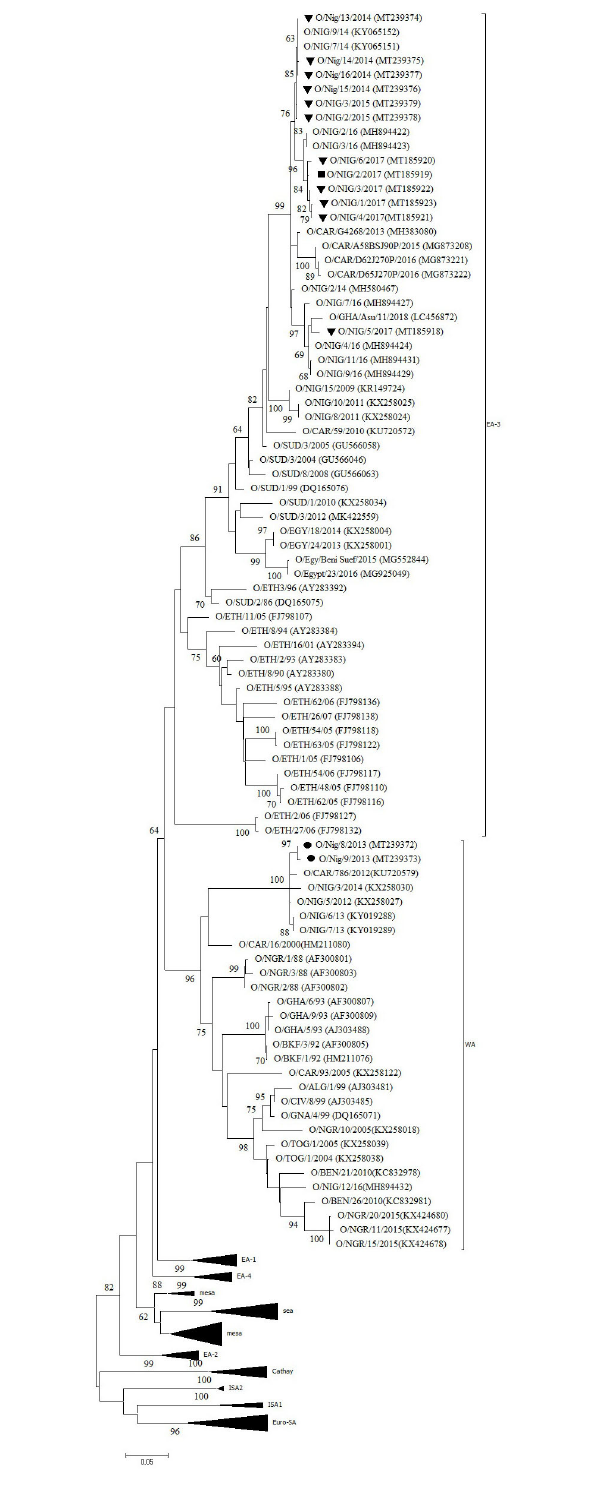
FIGURE 2 | VP1 phylogenetic tree for foot-and-mouth disease virus (FMDV) serotype O inferred using the maximum likelihood method based on the Tamura-Nei model. Branch lengths indicate the number of substitutions per site. Bootstrap values ≥ 60% are indicated at the nodes. Novel Nigerian FMDV from this study from Plateau is indicated with , from Kaduna with • and from Bauchi with (cid:4) .